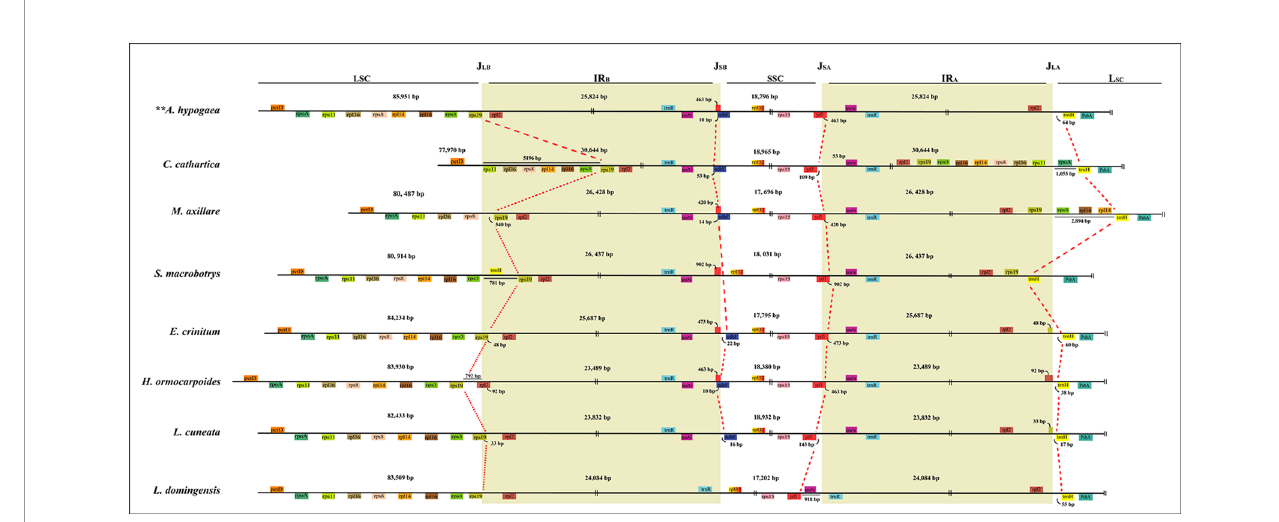
FIGURE 2 | Comparison of LSC, IRs, and SSC junction positions among plastomes of the MP clade. J LB , J SB , J SA , J LA refer to junctions of LSC/IR B , SSC/IR B , SSC/IR A , LSC/IR A ,